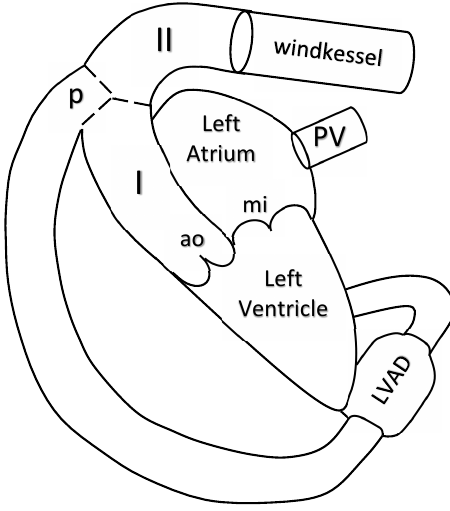
Figure 1. Scheme of the integrated model and notations used throughout the paper: left ventricle (lv), left atrium (la), pulmonary veins (pv), mitral valve (mi), aortic valve (ao), Windkessel compartment (WK), left ventricle assist device (LVAD), pump compartment